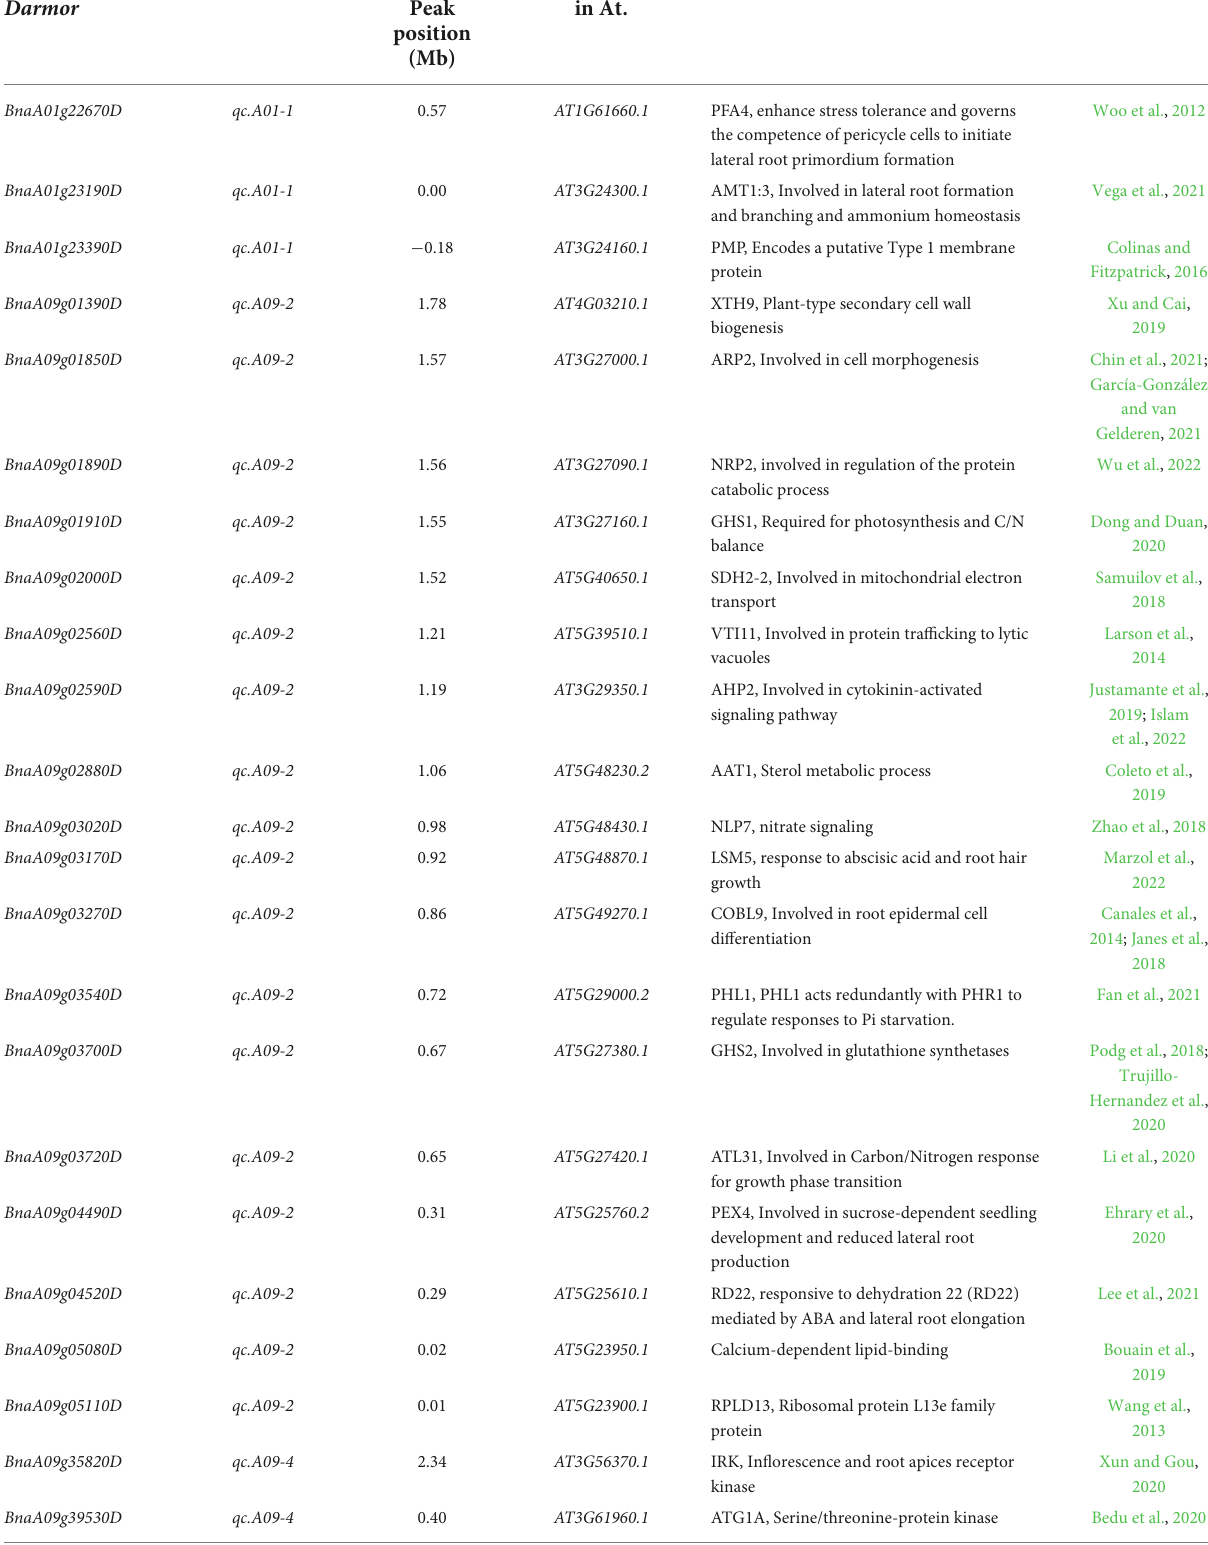
TABLE 4 Important candidate genes within the major quantitative trait loci (QTL) clusters related to root development/nutrient utilization. Homologs Gene ID in QTL cluster Distance to Darmor in Peak position (Mb)